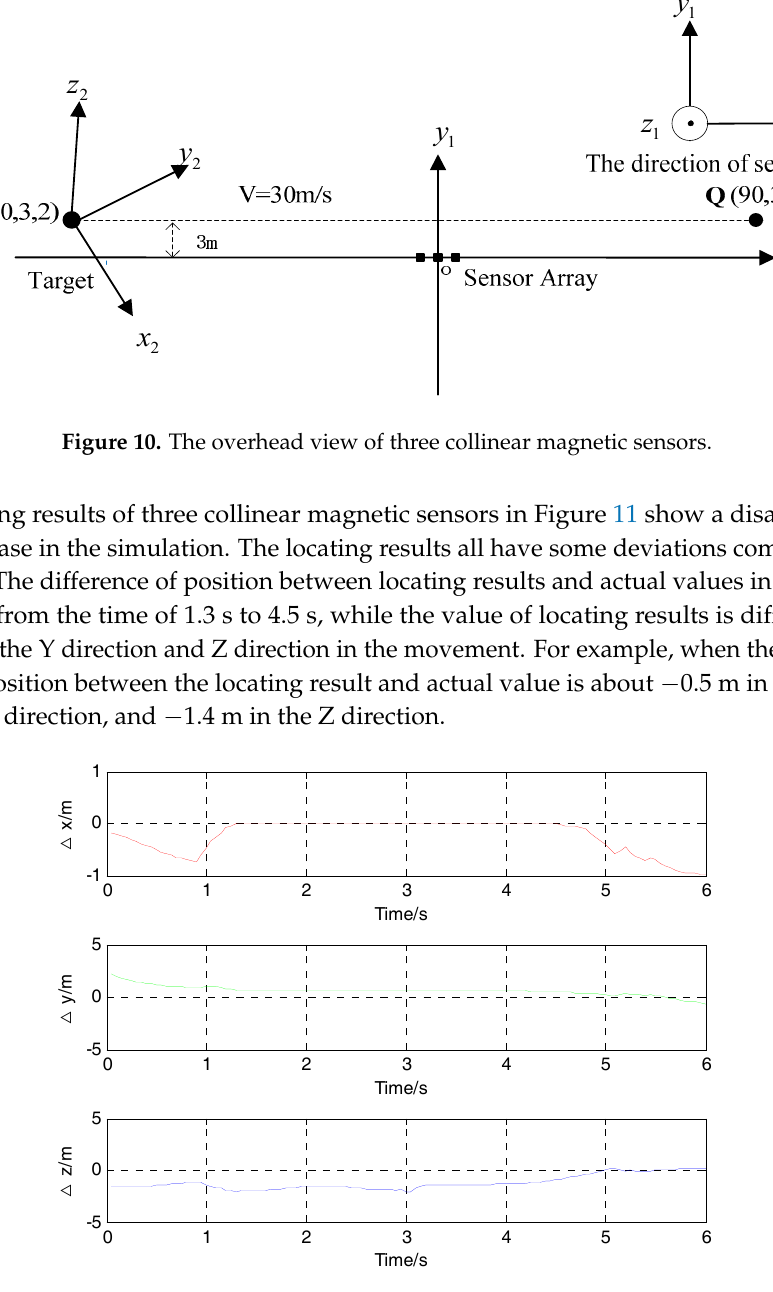
Figure 11. The difference of position between locating results and actual values in three directions.